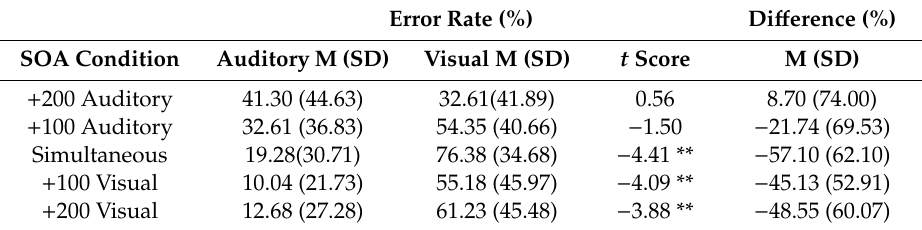
Table 6. Error rates and error rate di ff erence scores in the 3-button task. Means and standard deviations of rate of incorrect responding to bimodal oddballs, by type of error, and t statistics from pairwise comparisons. Means and standard deviations of error rate di ff